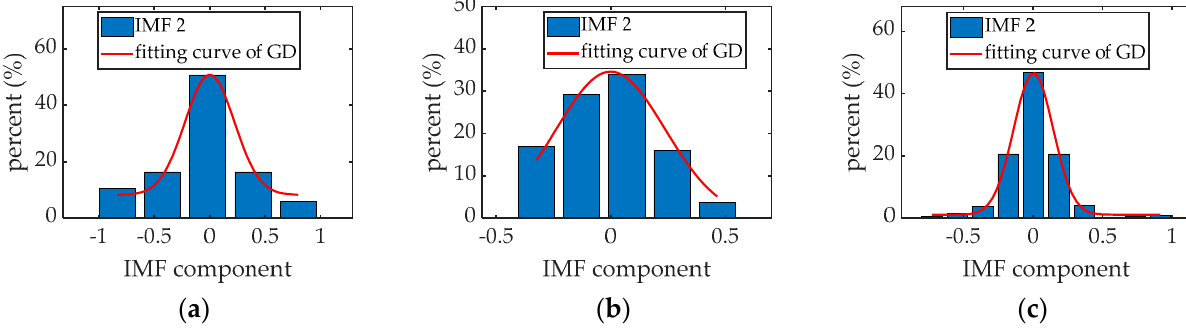
Figure 12. Statistical histogram of the IMF2 and GD-PDF-F curves. ( a ) 50–100 N•m; ( b ) 100–150 N•m; ( c )150–200 N•m. Table 5. Results of the signal denoising test.